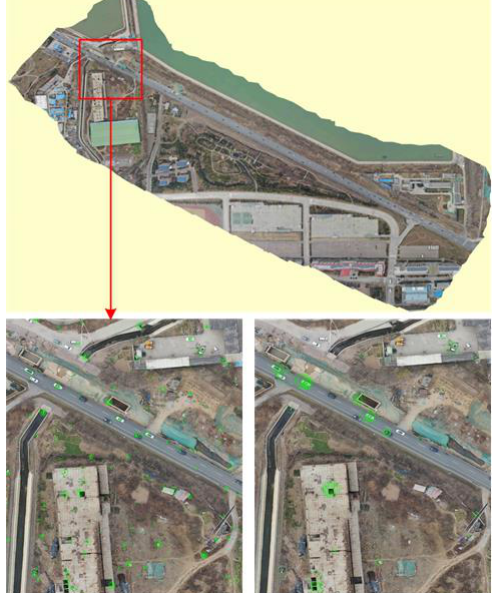
Figure 5. Feature detection comparison. The upper figure is the reference image, the lower left image is the feature